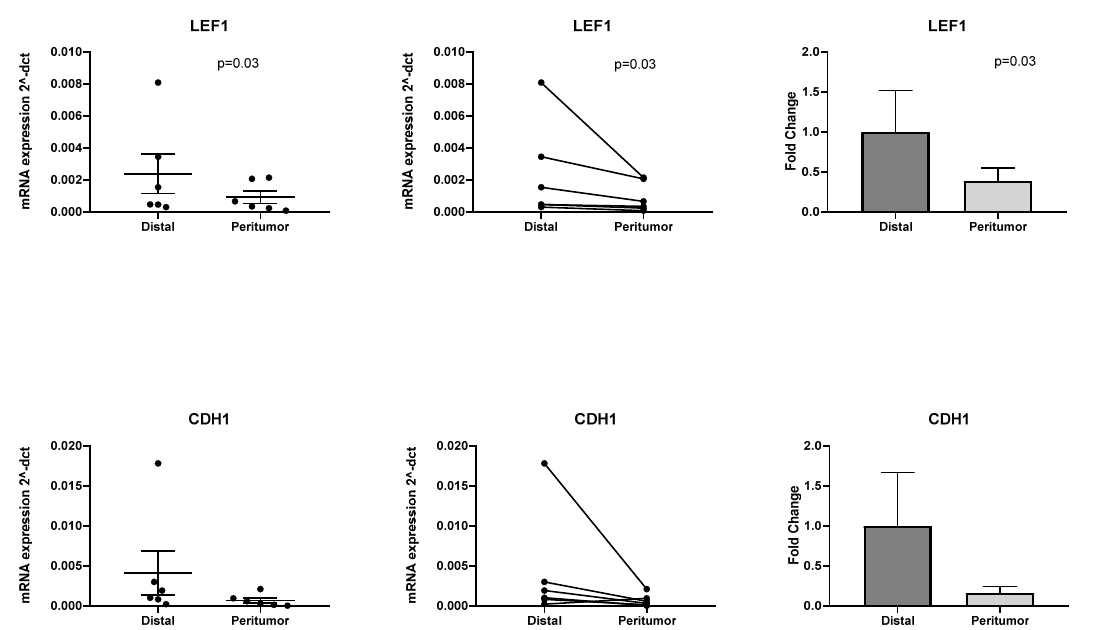
Figure 5. Validation with RT-PCR of 2 down-regulated genes identified with PanCancer pathway analysis ( LEF1 n = 6, p = 0.03; CDH1 n = 6, p = 0.09).